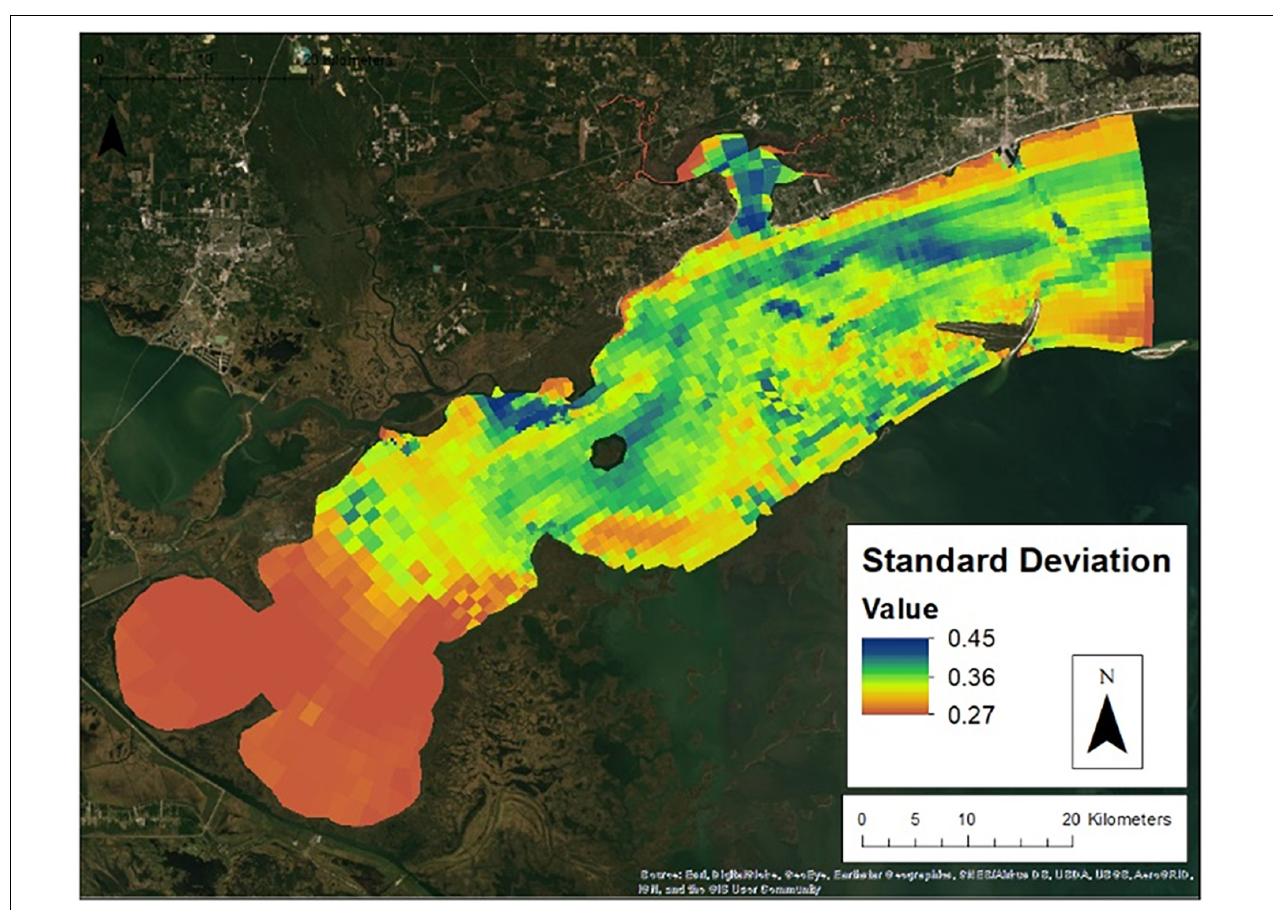
FIGURE 9 | Standard deviation of habitat suitability between the 2009/2010 and 2016/2017 oyster